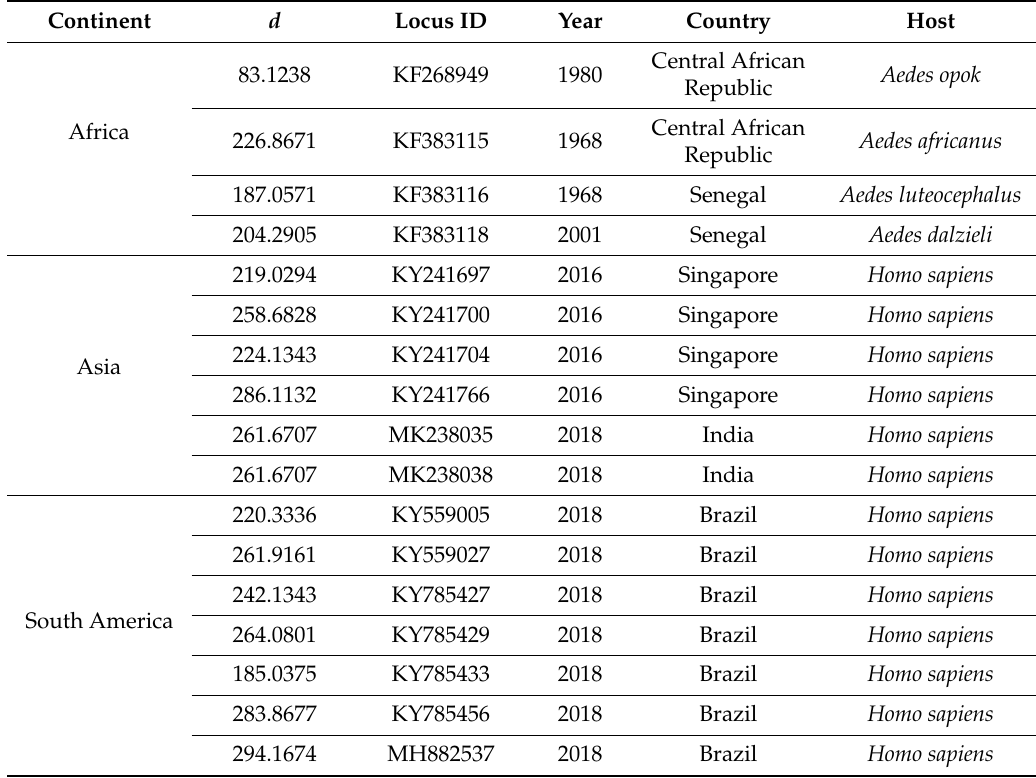
Table 5. The objects (virus samples) with Mahalanobis distance ( d ) larger than 180 (Average + 2*Standard